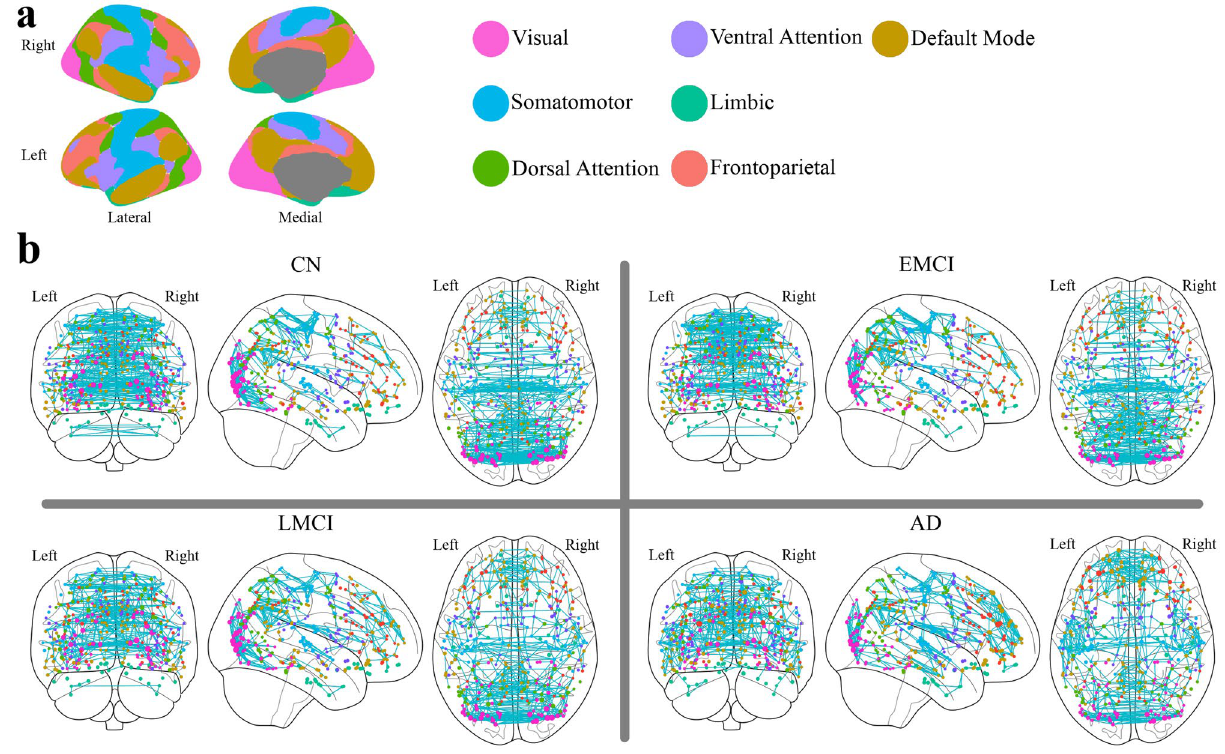
Figure 3. The overall gradually changing patterns of highly-weighted links are following a trend proportional to the disease progression. ( a ) The spatial distribution of the 7-module parcellation. ( b ) The top 1 percent highly- weighted links of each group network. Vertex color represents the module the vertex belongs to, and the vertex size is proportional to the vertex strength. It shows that there is a trend towards the increase in the number of default mode links as well as the decrease in the inter-hemisphere links in dorsal attention. Visualizations were created using ggseg 1.6.1 R package 54 ( a ) and Nilearn 0.6.2 (https:// nilea rn. github. io) ( b